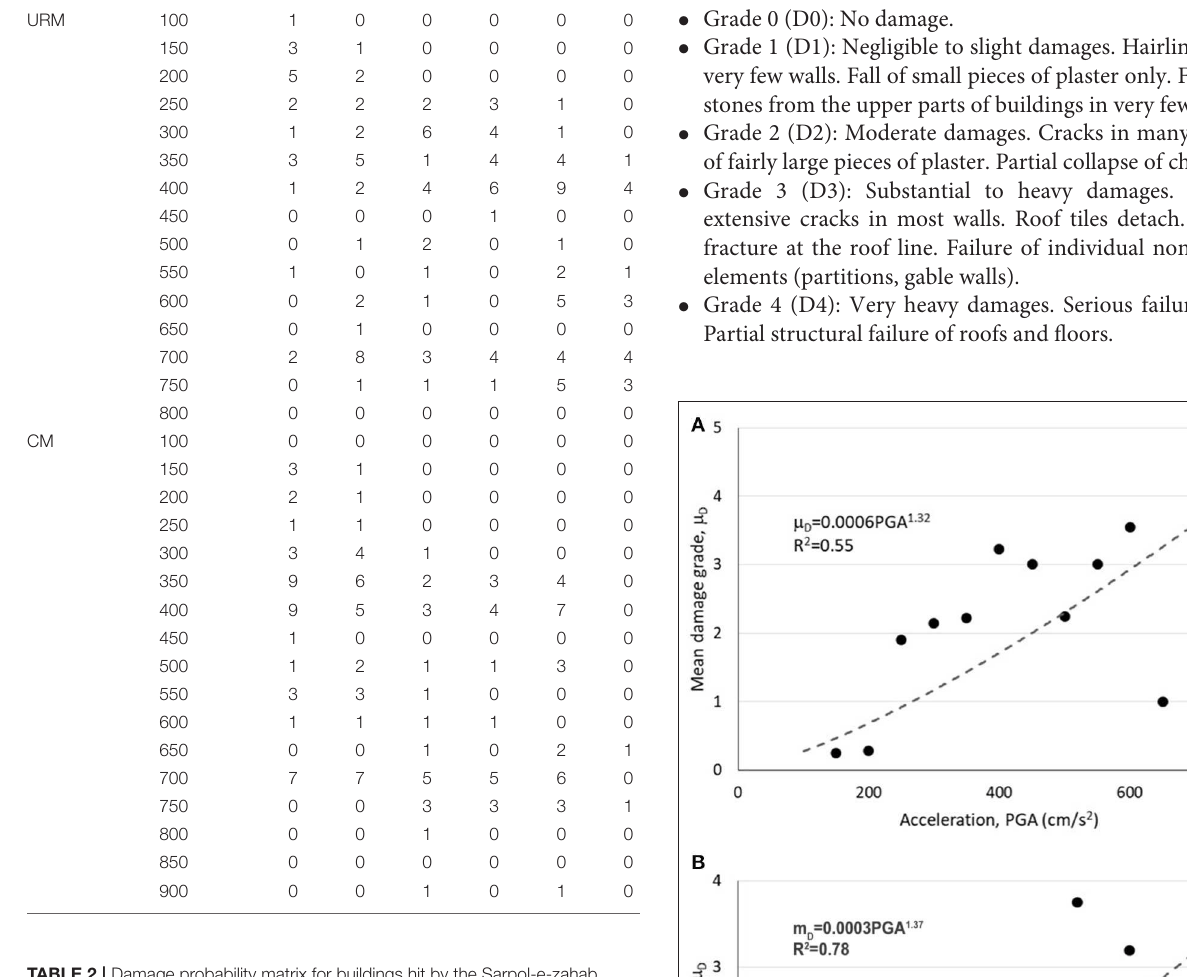
TABLE 2 | Damage probability matrix for buildings hit by the Sarpol-e-zahab earthquake: damage level vs. Intensity (EMS-98). Type